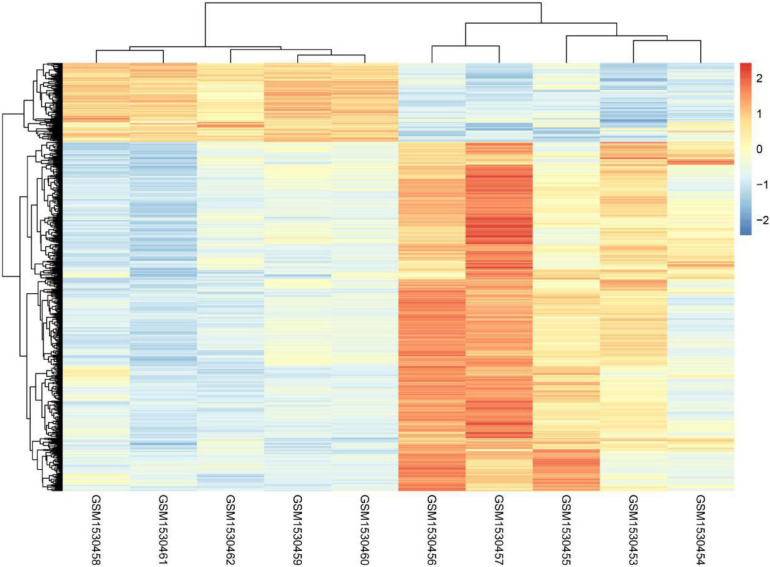
The heatmap analysis of GSE62628.